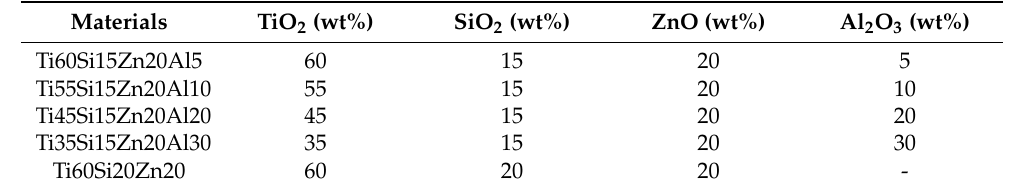
Table 1. wt% of materials used in production.